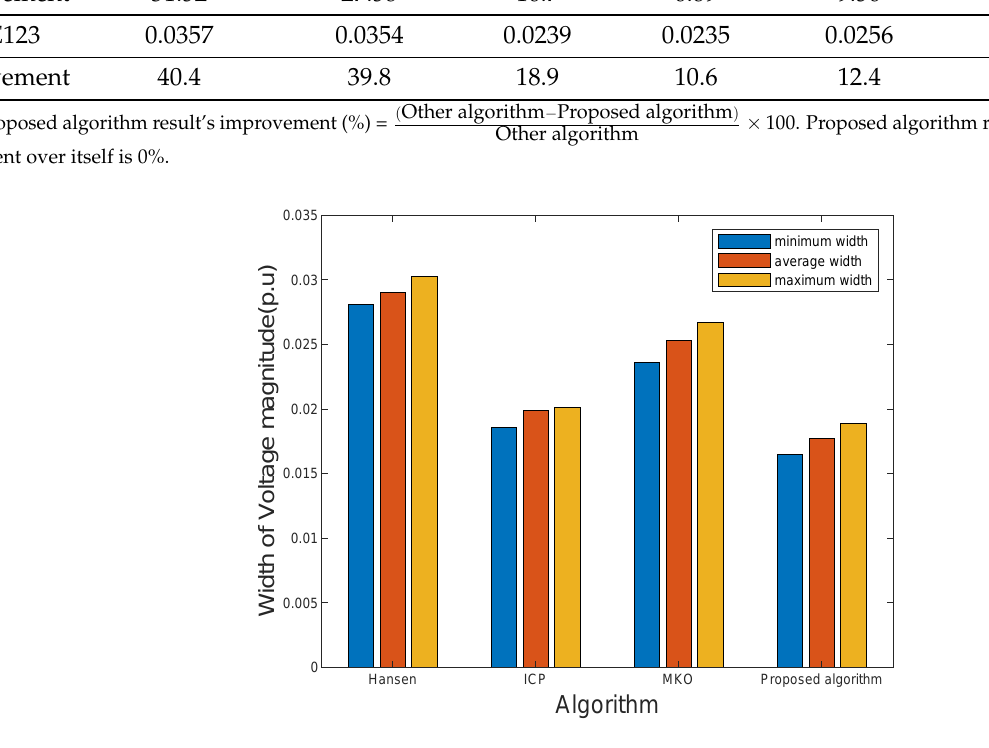
Figure 3. Comparison of bus voltage magnitude values in interval state estimation results on the IEEE 33 bus system.